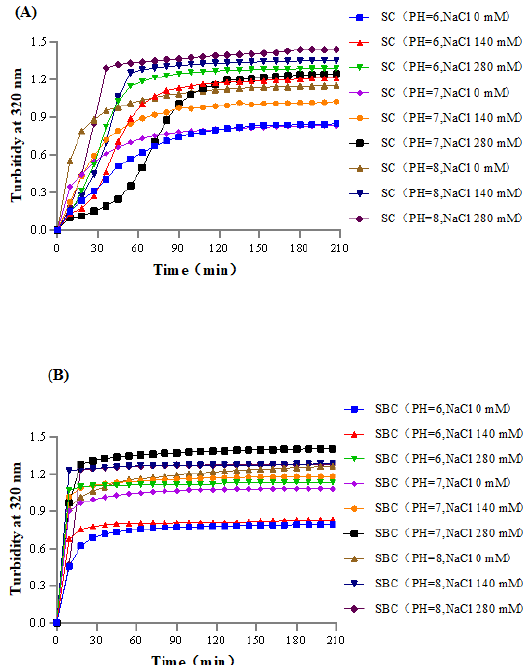
Figure 5. Effects of salinity and pH on the fibril formation in vitro of ( A ) skin collagen (SC) and ( B ) swim bladder collagen (SBC) from C. idella .